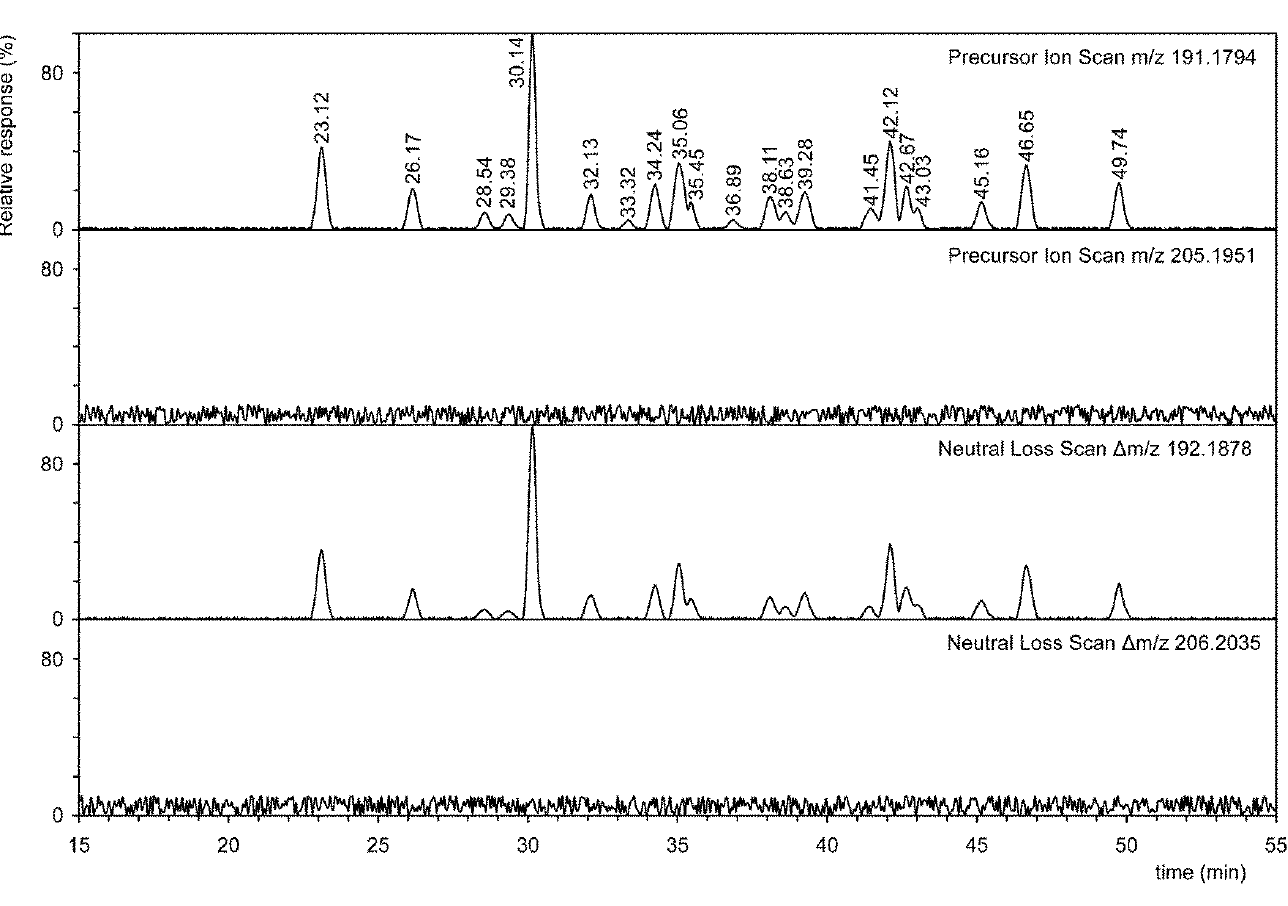
Figure 1. Liquid chromatography–mass spectrometry of the peracetylated hopanoids using high resolution NLS and PIS.